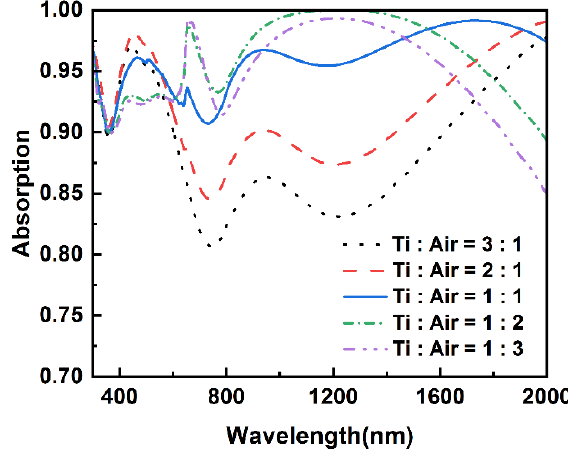
Figure 6. Absorptive spectra of absorber with different height ratios of Ti to air nanopillar, of which the radii are fixed to 95 nm and 120 nm.